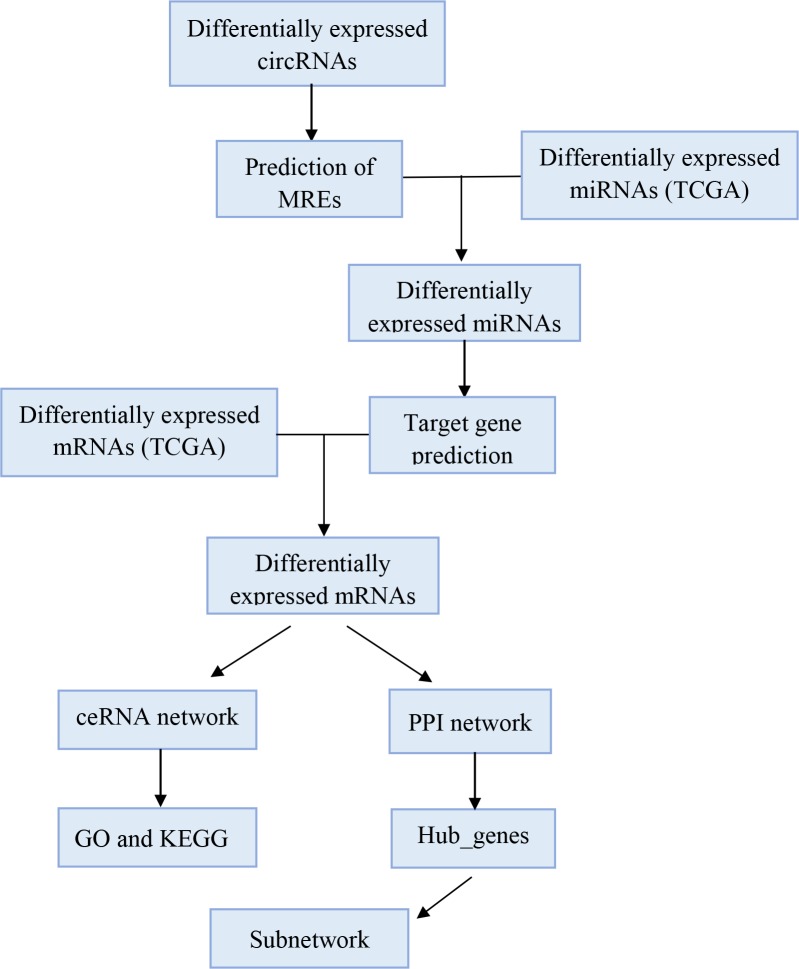
The flowchart of ceRNA network analysis.